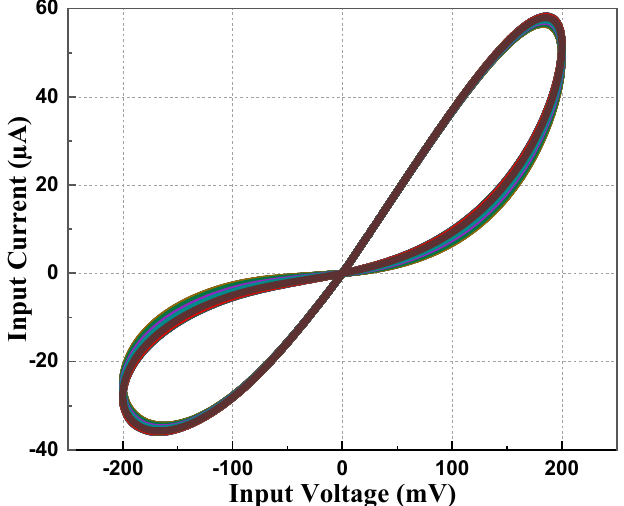
Sensors 2023 , 23 , x FOR PEER REVIEW Figure 12. Monte Carlo simulation at 5 MHz with 10 pF. Figure 12. Monte Carlo simulation at 5 MHz with 10 pF. Figure 12. Monte Carlo simulation at 5 MHz with 10 pF.